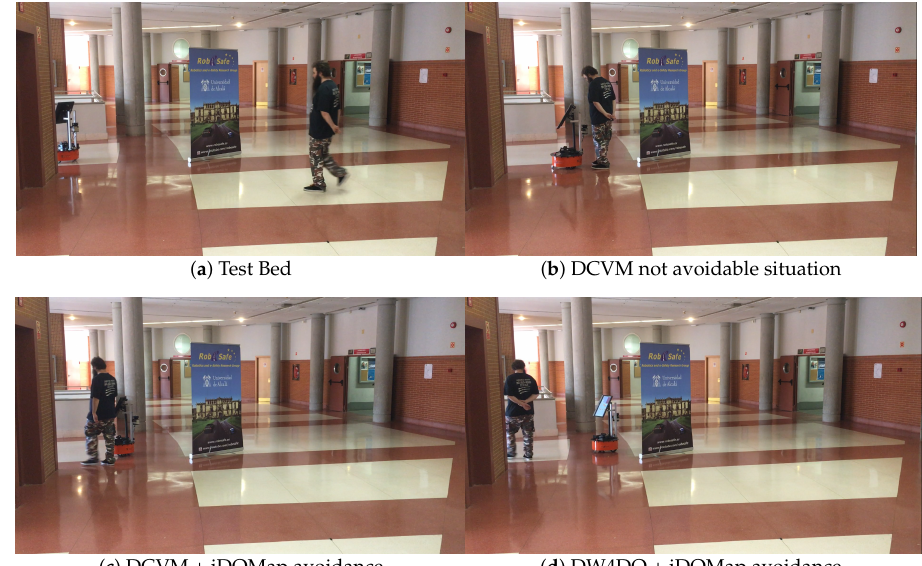
Figure 29. Scenario 2—Images